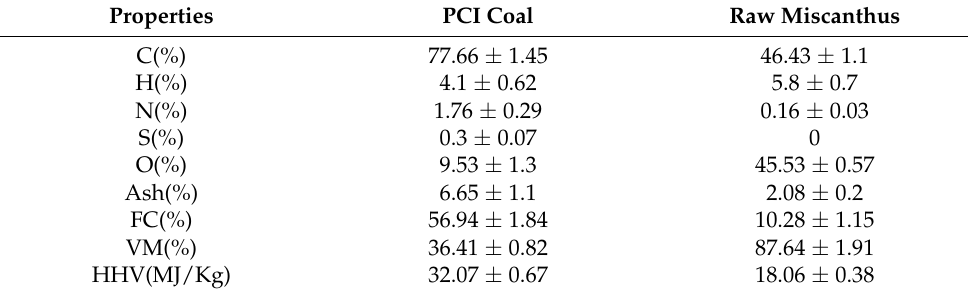
Table 1. Physicochemical properties of PCI coal and raw miscanthus.